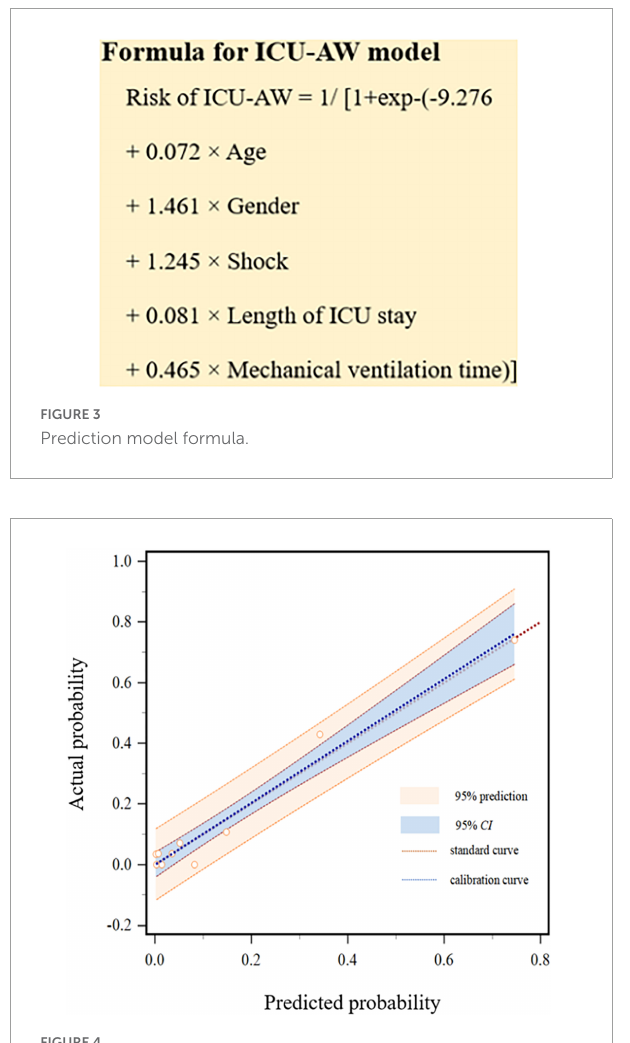
FIGURE4 Calibration degree of the logistic regression model.